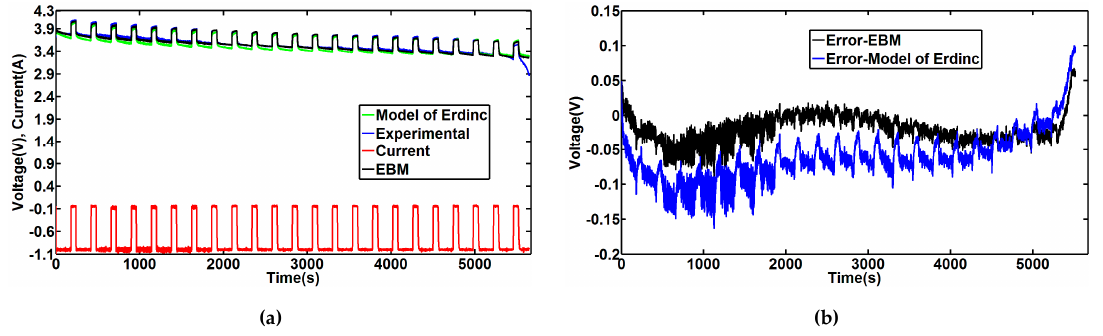
Figure 10. Simulation and experimental curves for 1A current ( a ) voltages and current, ( b ) voltages error.